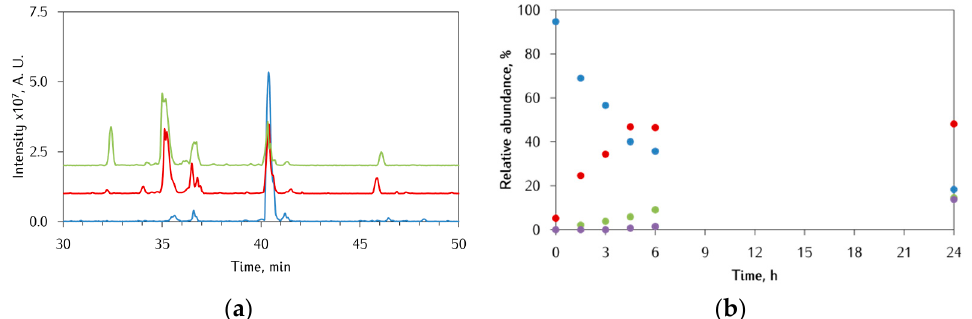
Figure 10. ( a ) HPLC-MS elution pro fi les of Ac- α S p S 119–132 (20 µM) in Mops bu ff er pH 7.0 at 37 °C, in the presence of Fe II (10 µM) and DA (20 µM) at the beginning (blue), and after 6 h (red) and 24 h of incubation (green). ( b ) Per cent modi fi cation detected by HPLC-MS analysis: Ac- α S p S 119–132 (t r 40 min, blue), Ac- α S p S 119–132 +16 (t r 34.6 min, red), Ac- α S p S 119–132 +32 (t r 36.4 min, green), Ac- 119 DPDNEAYEM* 127 fragment (t r 32 min, purple).